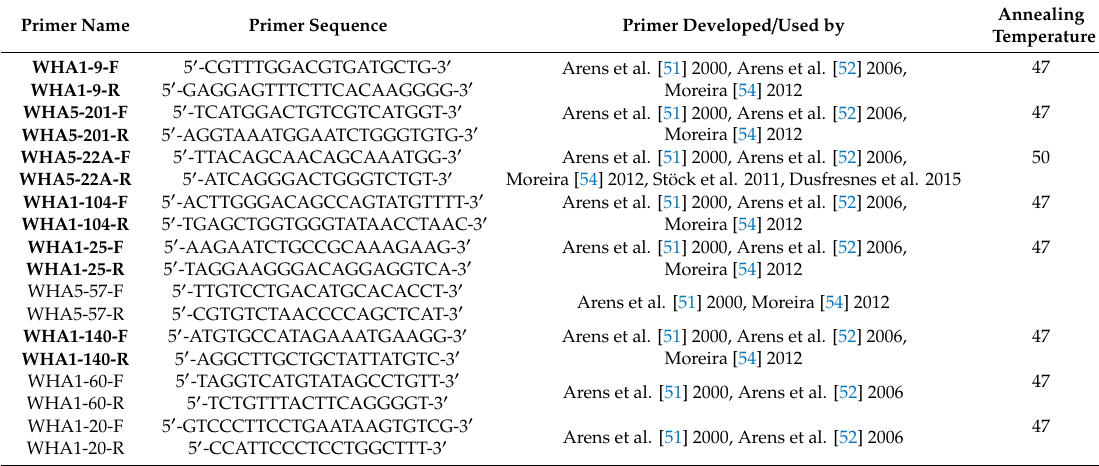
Table 1. Microsatellite markers tested for cross-amplification in Dryophytes japonicus and Dryophytes suweonensis. The six microsatellite primer pairs for which cross-amplification was successful are in bold. These microsatellites were used to test hybridisation between Korean